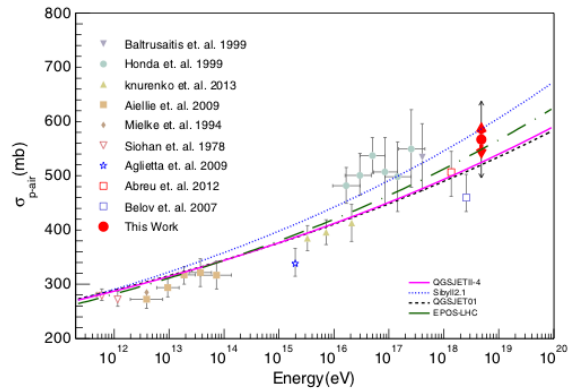
Figure 4. The (cid:27) inel obtained by various experiments. The re- p (cid:0) air sult of this work is shown by a red filled circle with statistical and systematic errors indicated by long and short arrows, respec- tively. The prediction lines of 4 di ff erent interaction models are also drawn. (Figure from [5].)